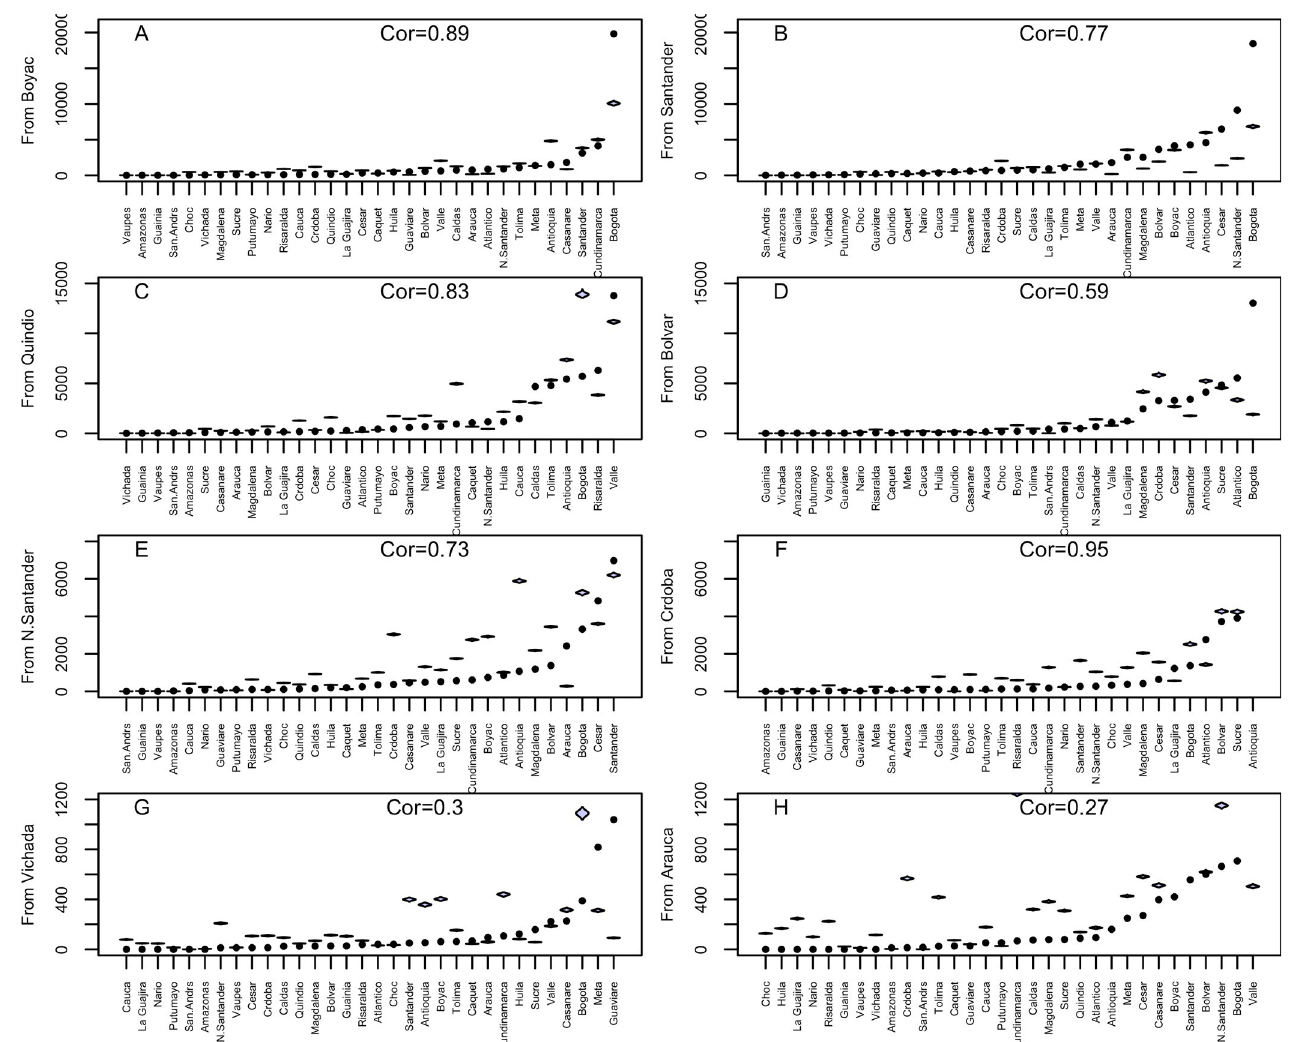
Fig 6. Predicted versus observed migration flows (sorted by magnitude) in eight departments characterized by (A & B) high, (C & D) medium, (E & F) low, and (G & H) very low incoming migration flows. The shaded violin plots show the 95% confidence interval based on the joint posterior sample parameters, while the black dots represent the observed flows. The four categories were selected based on the maximum number of migrants each department would receive based on our estimates, with each of the four departments selected randomly from each quartile.